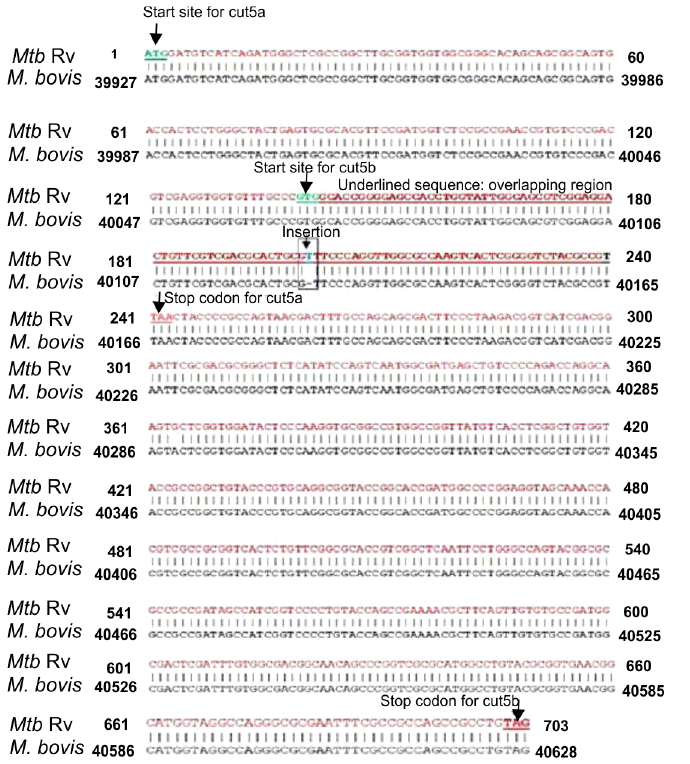
Fig 1. Complete nucleotide sequences of the genes encoding Cut5a and Cut5b (in M . tuberculosis H37Rv) and Cut5 (in M . bovis ).